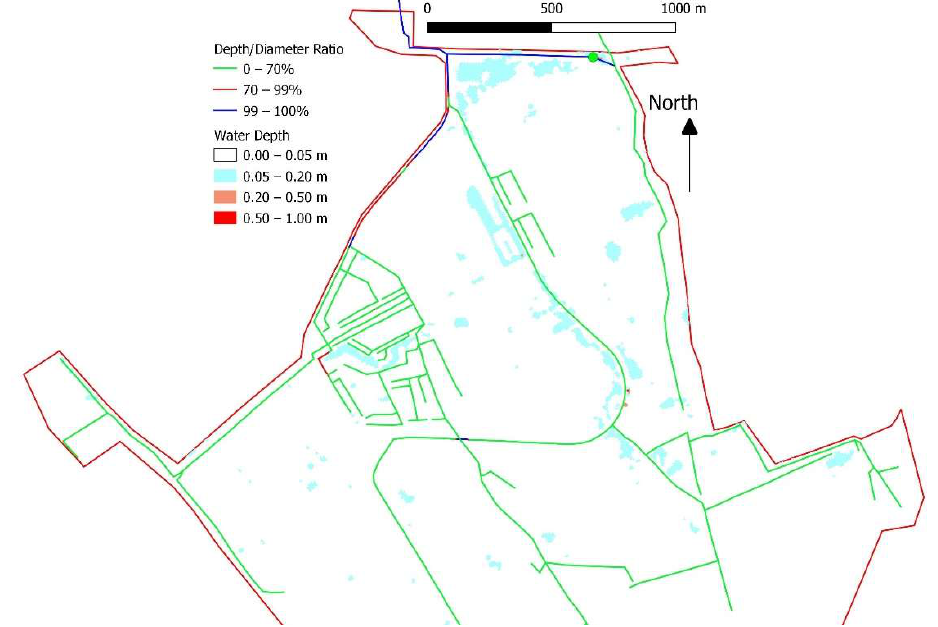
Figure 11. Results of validation event on 11 September 2021 (rain 8.4 mm). Part-full pipe flow (green lines) and surcharging pipe (blue lines). The green point indicates the local overflow at Piazza Castelforte.